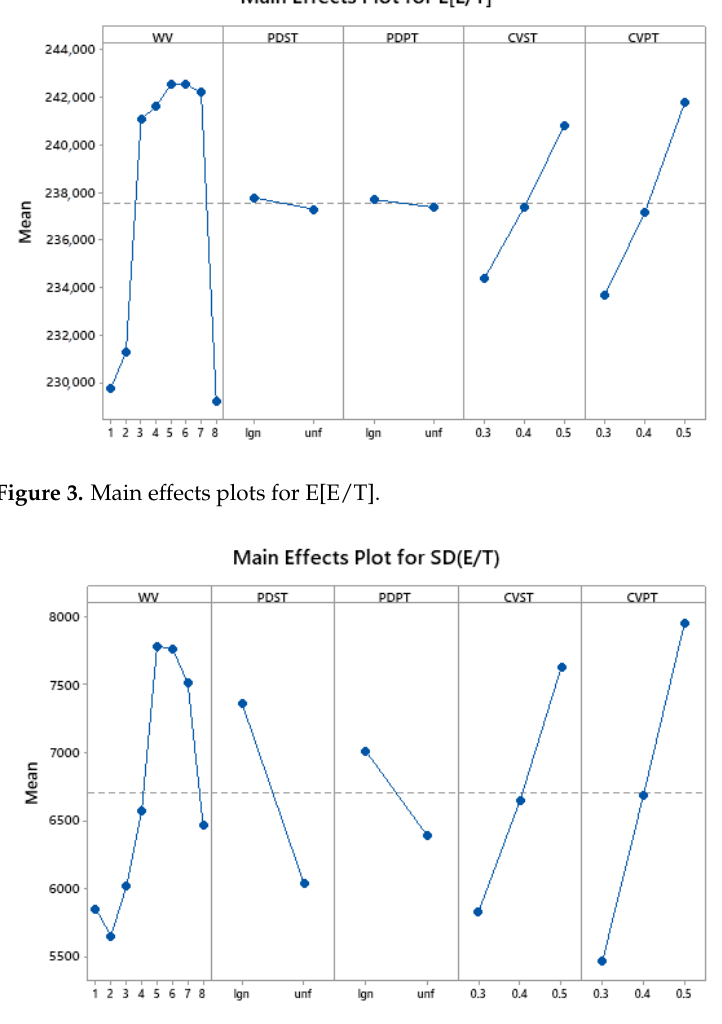
Figure 4. Main effects plots for